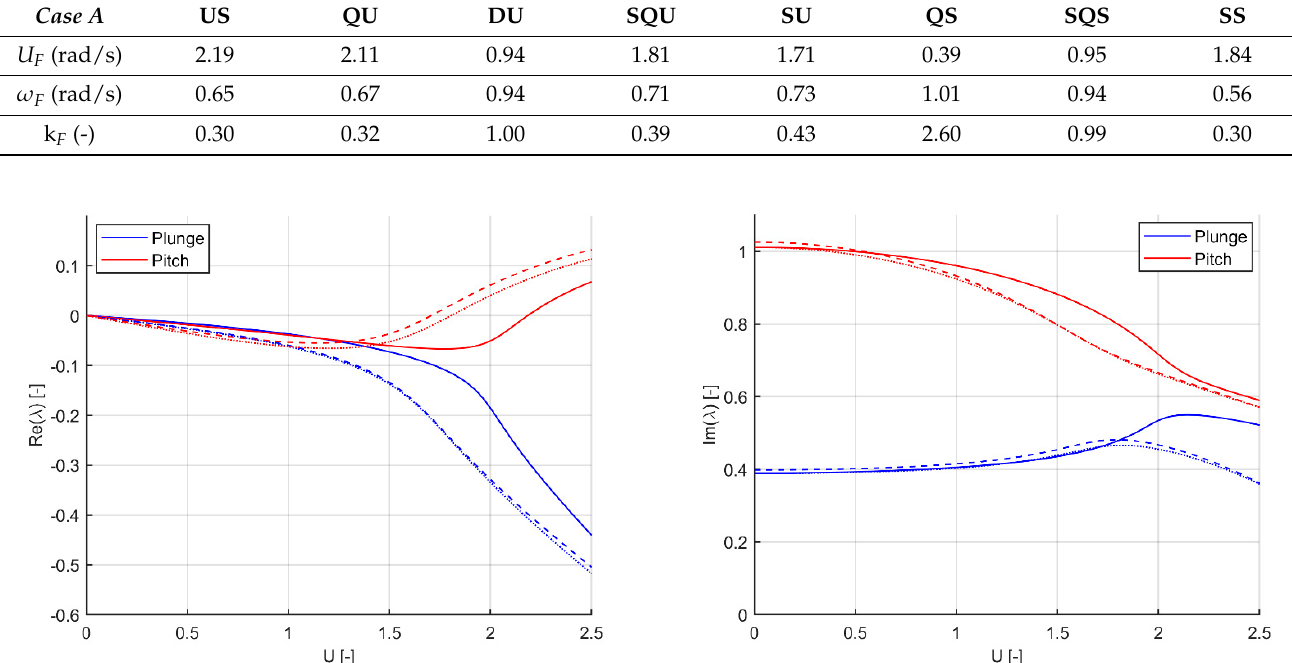
Figure 3. Evolution of the complex eigenvalues for Case A: real part ( left ), imaginary part ( right ); continuous, dashed and dotted lines for US, SU and SQU aerodynamic models, respectively.